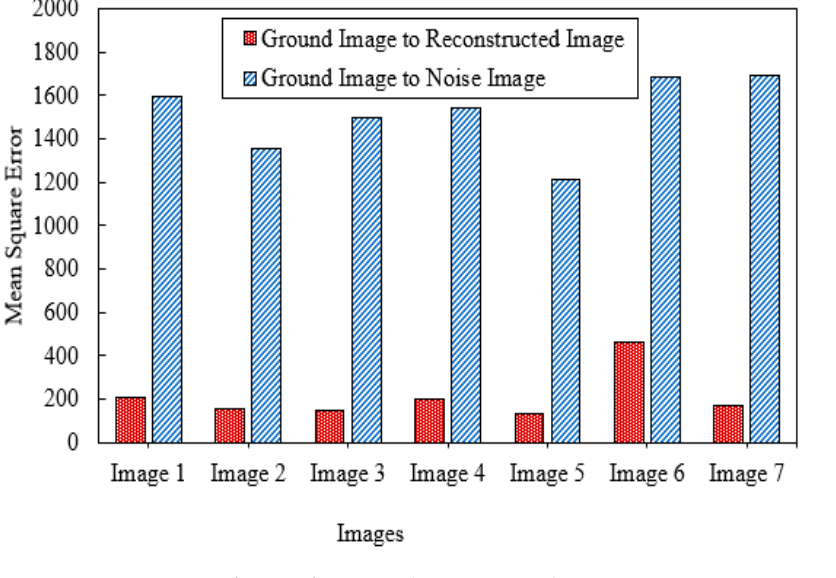
Figure 6. Comparison of MSE of noise and reconstructed images. SSIM of two images, x and y can be calculated